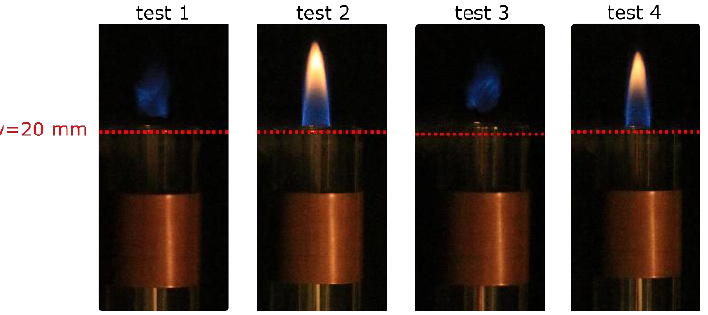
Figure 5. Impact of the stand-off distance ( S SO ) on the flame at fixed V pp in comparison with the clean case (test 1). Test 2 at S SO = − 40 mm; tests 3 and 4 at S SO = 20 mm. case (test 1). Test 2 at S SO = − 40 mm; tests 3 and 4 at S SO = 20